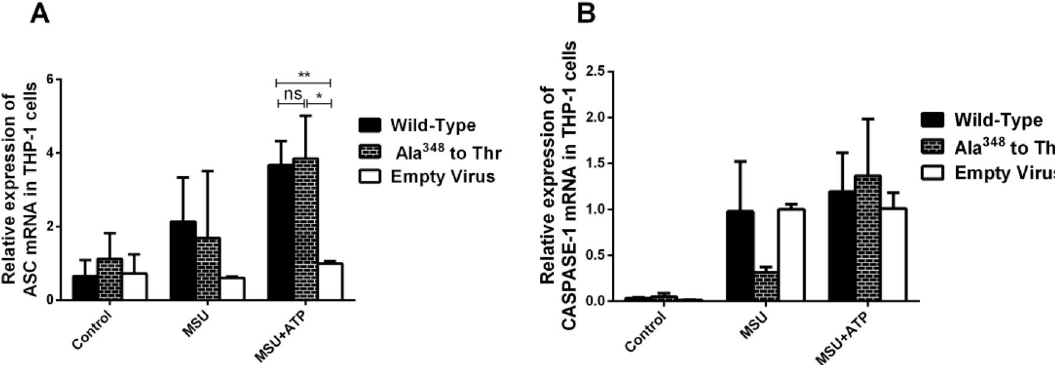
Figure 4. The ASC and Caspase-1 levels in the Ala 348 to Thr mutation. ( A ) ASC mRNA expression in Ala 348 to Thr, Wild-Type and Empty Virus. ( B ) Caspase-1 mRNA expression in Ala 348 to Thr, Wild-Type and Empty Virus groups. * P < 0.05, ** P <